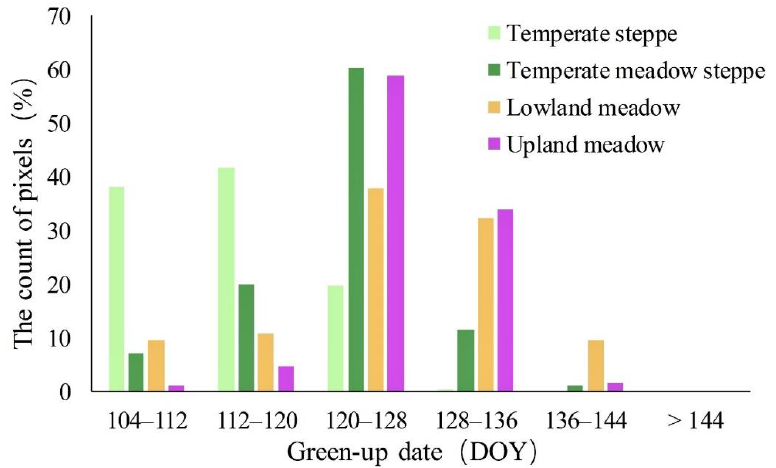
Figure 8. Green-up dates in the different types of grasslands. The trends in green-up dates decreased from the west and east to the central region (Figure 9) and ranged from −15 days per decade to 15 days per decade. The mean trend